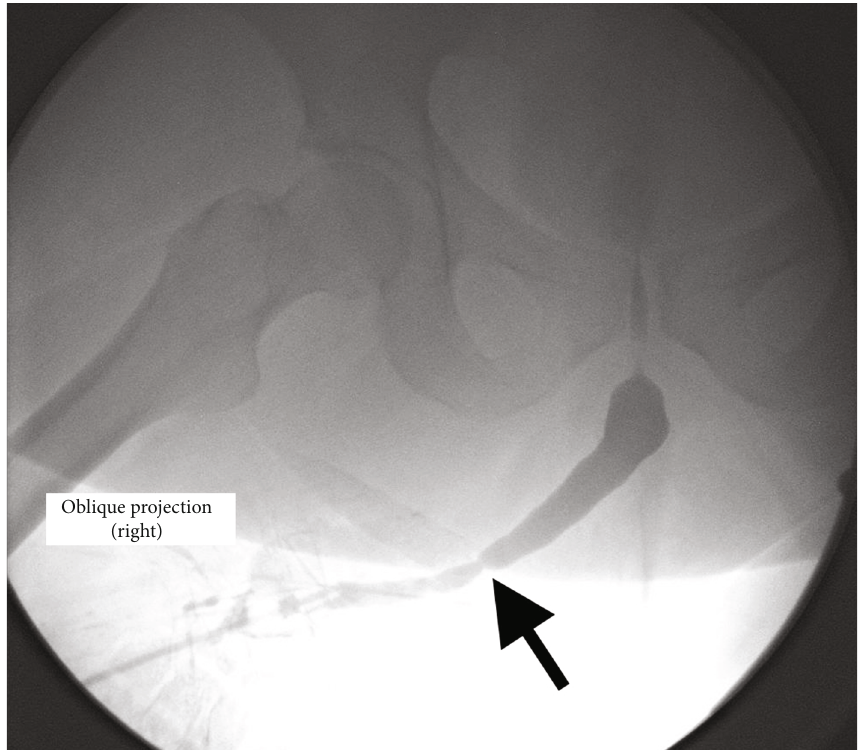
Figure 2: Retrograde urethrogram showing a stricture in the junction between the neourethra and the native bulbar urethra